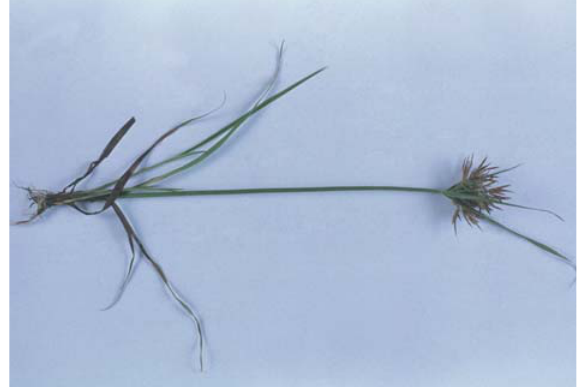
FIG. 6 Drop in serum prolactin concentration (mean " SD) in five sheep ewes fed the suspect maize silage in the first outbreak. The regression curve for the dependant vari- able PRL is described by y = 3.870606 – 0.378650 x